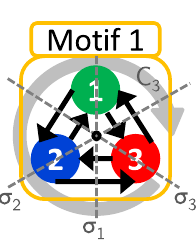
FIG. 8. Graphic illustration of symmetry axes σ 1 ; 2 ; 3 and the cyclic rotation symmetry C perpendicular to the plane of the